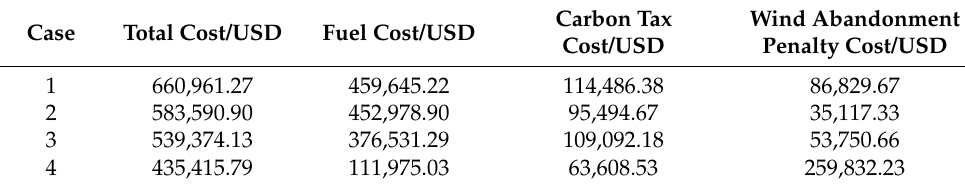
Table 1. Costs of objective functions in Cases 1–4.